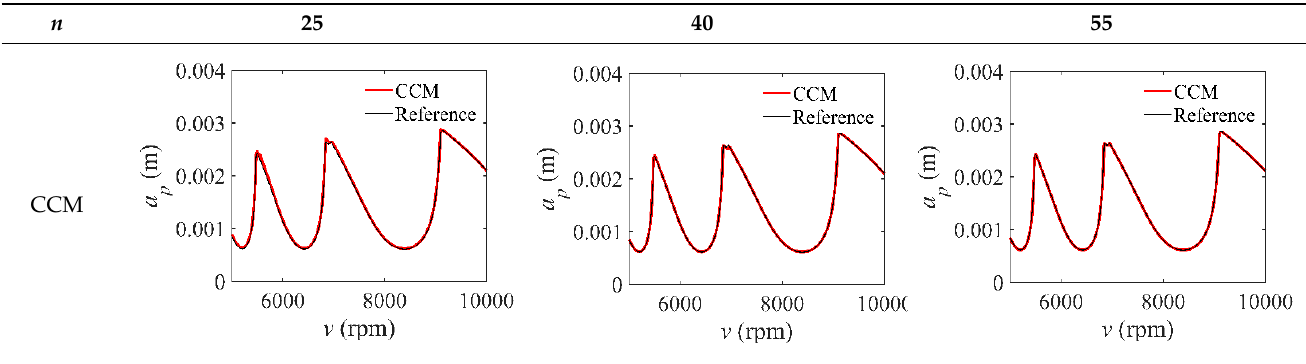
Table 3. Stability lobe diagrams of the CCM, SDM, and SEM when a / D = 0.5.